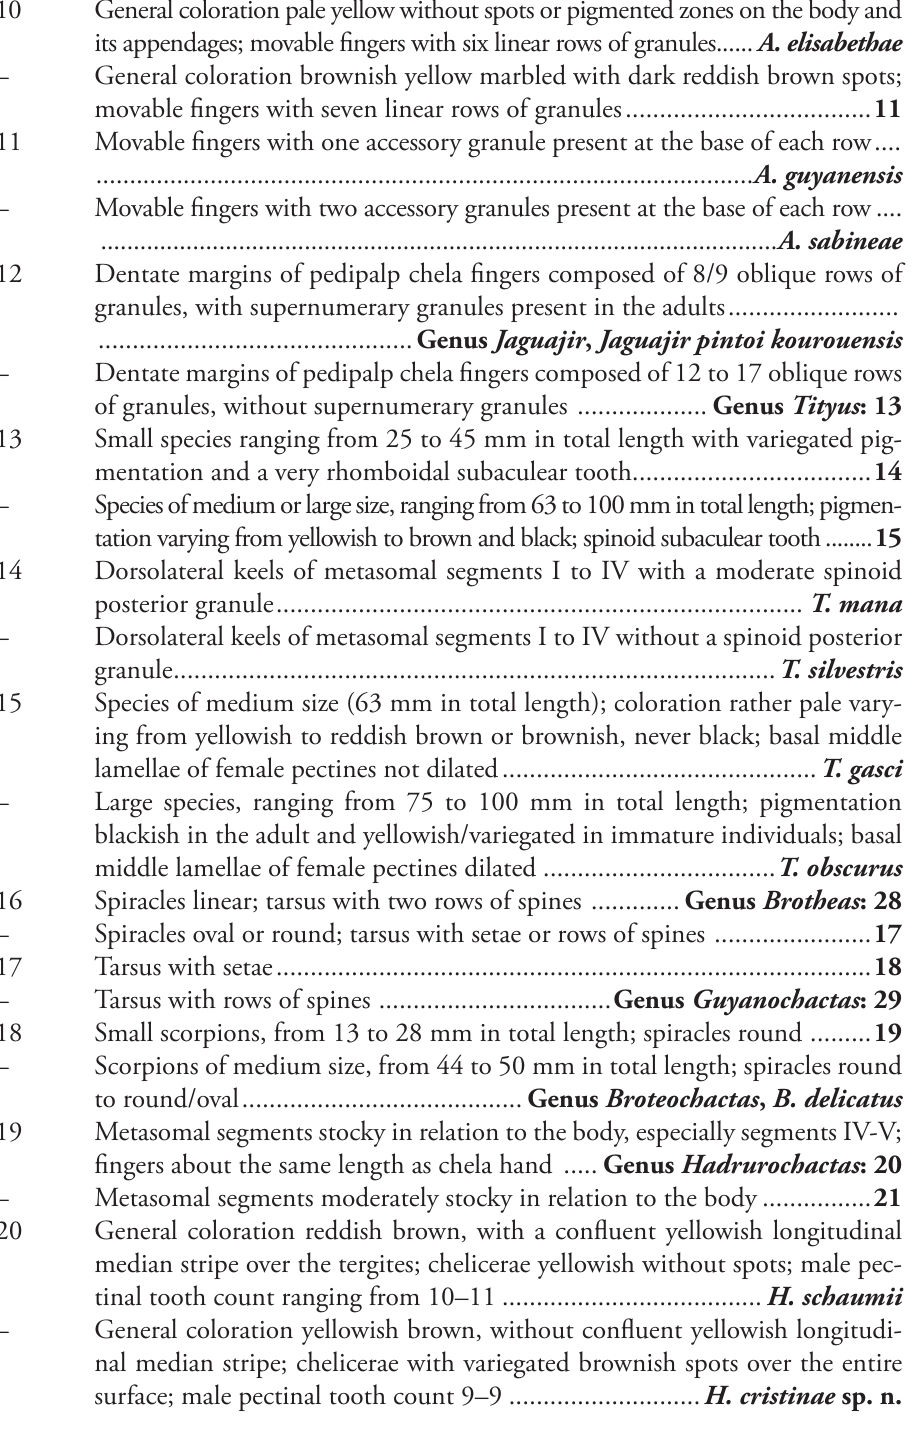
General coloration pale yellow without spots or pigmented zones on the body and its appendages; movable fingers with six linear rows of granules ...... A. elisabethae – General coloration brownish yellow marbled with dark reddish brown spots; movable fingers with seven linear rows of granules .................................... 11 11 Movable fingers with one accessory granule present at the base of each row .... .................................................................................................. A. guyanensis – Movable fingers with two accessory granules present at the base of each row .... ....................................................................................................... A. sabineae 12 Dentate margins of pedipalp chela fingers composed of 8/9 oblique rows of granules, with supernumerary granules present in the adults ......................... .............................................. Genus Jaguajir , Jaguajir pintoi kourouensis – Dentate margins of pedipalp chela fingers composed of 12 to 17 oblique rows of granules, without supernumerary granules ................... Genus Tityus : 13 13 Small species ranging from 25 to 45 mm in total length with variegated pig- mentation and a very rhomboidal subaculear tooth................................... 14 – Species of medium or large size, ranging from 63 to 100 mm in total length; pigmen- tation varying from yellowish to brown and black; spinoid subaculear tooth ........ 15 14 Dorsolateral keels of metasomal segments I to IV with a moderate spinoid posterior granule ............................................................................. T. mana – Dorsolateral keels of metasomal segments I to IV without a spinoid posterior granule ........................................................................................ T. silvestris 15 Species of medium size (63 mm in total length); coloration rather pale vary- ing from yellowish to reddish brown or brownish, never black; basal middle lamellae of female pectines not dilated .............................................. T. gasci – Large species, ranging from 75 to 100 mm in total length; pigmentation blackish in the adult and yellowish/variegated in immature individuals; basal middle lamellae of female pectines dilated .................................. T. obscurus 16 Spiracles linear; tarsus with two rows of spines ............. Genus Brotheas : 28 – Spiracles oval or round; tarsus with setae or rows of spines ....................... 17 17 Tarsus with setae ....................................................................................... 18 – Tarsus with rows of spines .................................. Genus Guyanochactas : 29 18 Small scorpions, from 13 to 28 mm in total length; spiracles round ......... 19 – Scorpions of medium size, from 44 to 50 mm in total length; spiracles round to round/oval ......................................... Genus Broteochactas , B. delicatus 19 Metasomal segments stocky in relation to the body, especially segments IV-V; fingers about the same length as chela hand ..... Genus Hadrurochactas : 20 – Metasomal segments moderately stocky in relation to the body ................ 21 20 General coloration reddish brown, with a confluent yellowish longitudinal median stripe over the tergites; chelicerae yellowish without spots; male pec- tinal tooth count ranging from 10–11 ...................................... H. schaumii – General coloration yellowish brown, without confluent yellowish longitudi- nal median stripe; chelicerae with variegated brownish spots over the entire surface; male pectinal tooth count 9–9 ............................ H. cristinae sp.